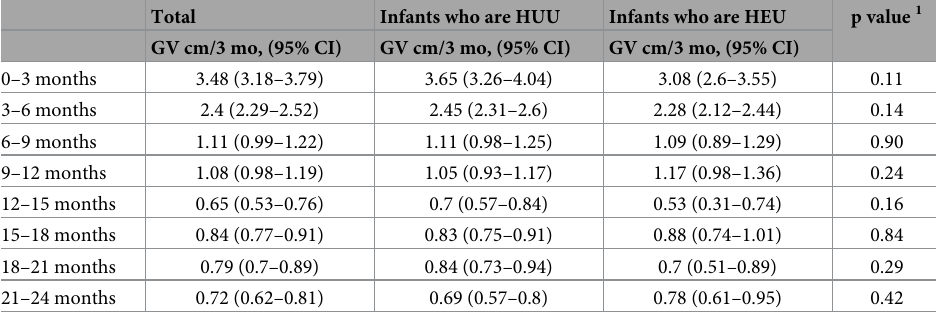
Table 2. Growth velocity for 3 months length